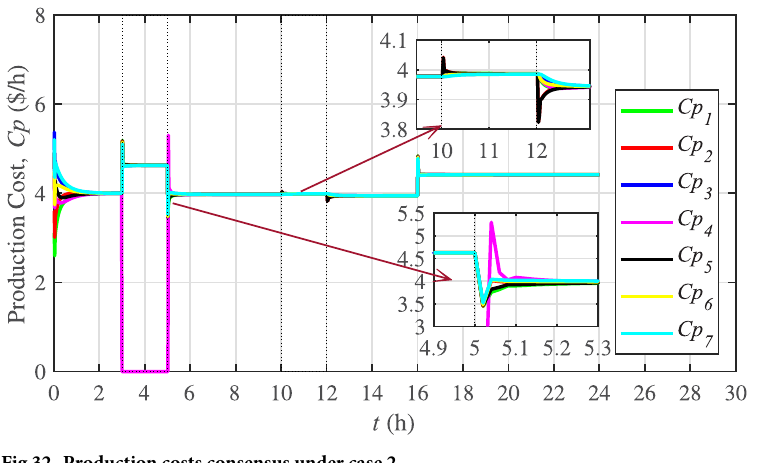
Fig 32. Production costs consensus under case 2.